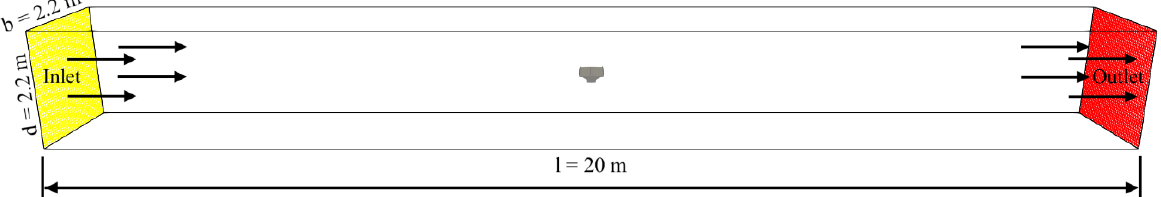
Figure 7. Computational domain used in simulations.